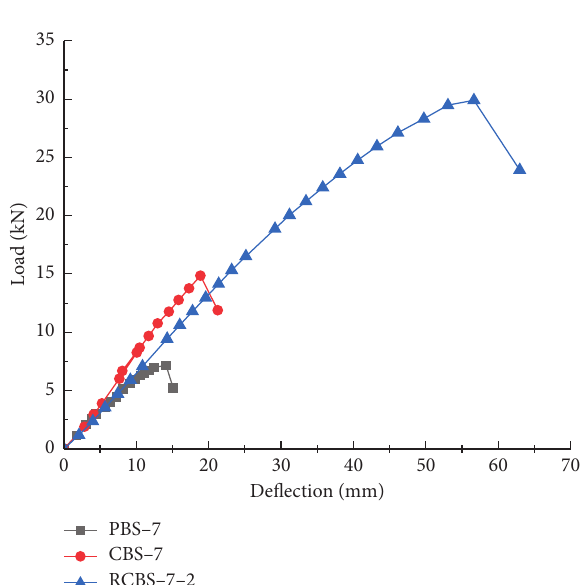
Figure 11: Comparison of composite slabs with different reinforcement methods.